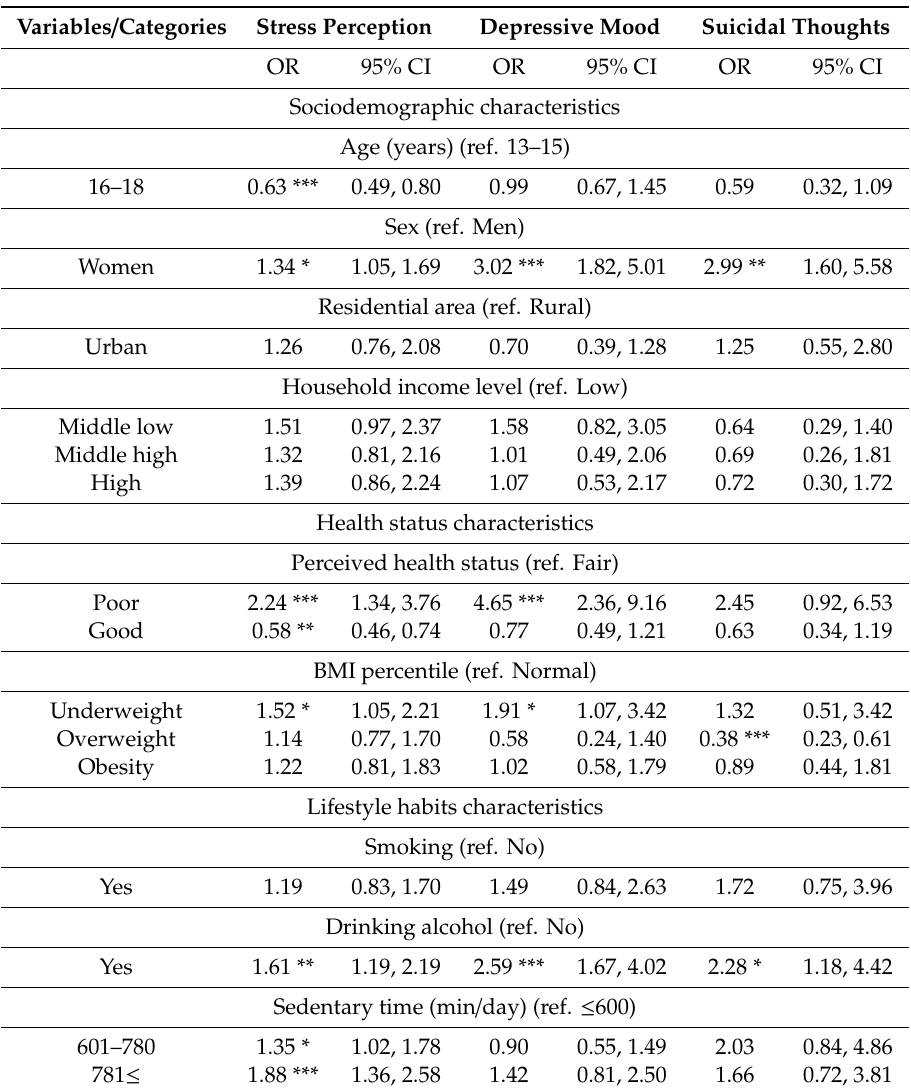
Table 3. Multi-nominal logistic regression to compare factors associated with mental health problems a . Variables / Categories Stress